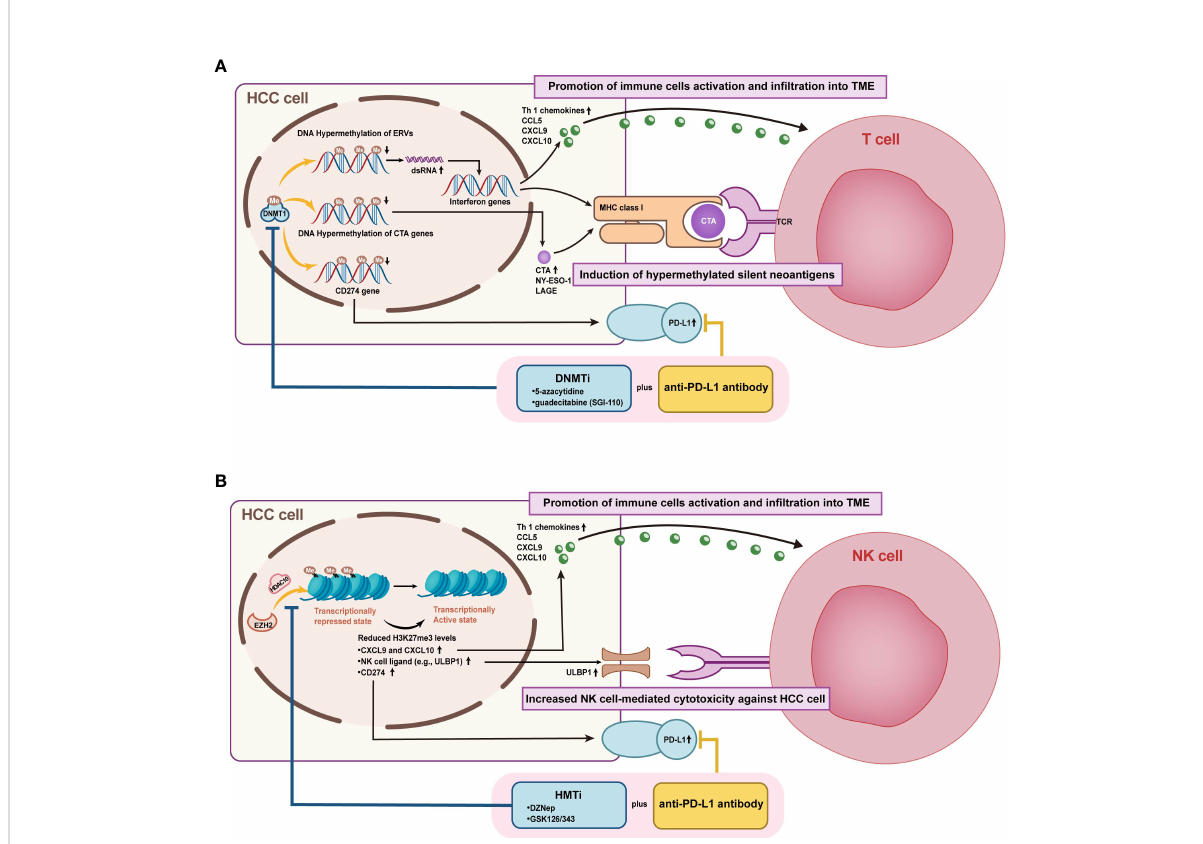
FIGURE 7 Mechanisms of combined epigenetic and immunotherapeutic strategies for HCC treatment. (A) Figure A illustrates the enhanced ef fi cacy of DNMTi combined with ICIs by promoting immune cell activation and in fi ltration into TME and inducing hypermethylated silenced neoantigen expression. (B) Figure B demonstrates that HMTi combined with ICIs promotes immune cell activation and in fi ltration to TME and enhances NK cell-mediated HCC killing by upregulating the expression of chemokines, PD- L1, and NK cell ligand, which are inhibited by high histone